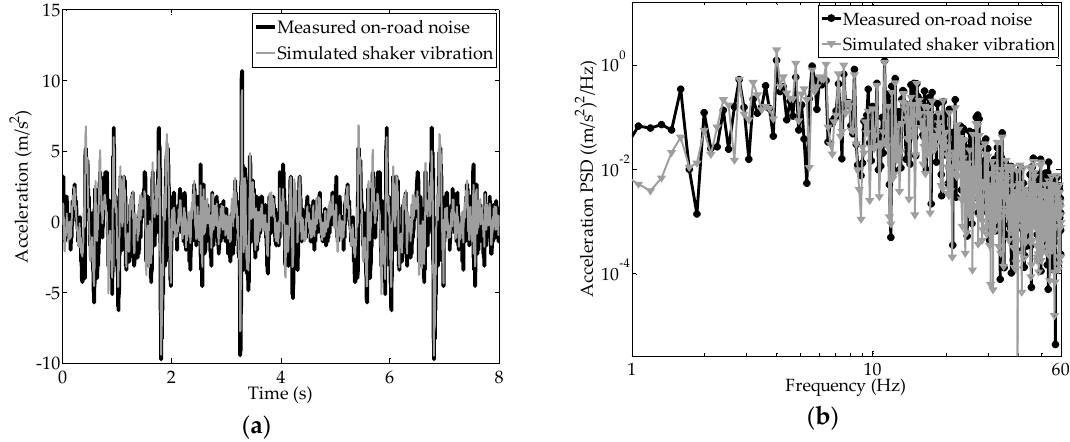
Figure 9. ( a ) Acceleration regeneration of the measured on-road noise for the shaker; ( b ) power spectrum density comparison of the measured on-road noise and simulated shaker vibration.